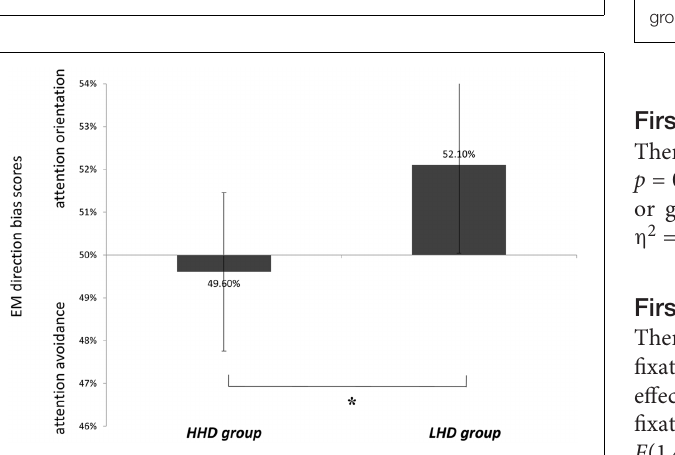
FIGURE 2 | Eye-movement direction bias scores among HHD group and LHD group. ∗ p < 0.05.